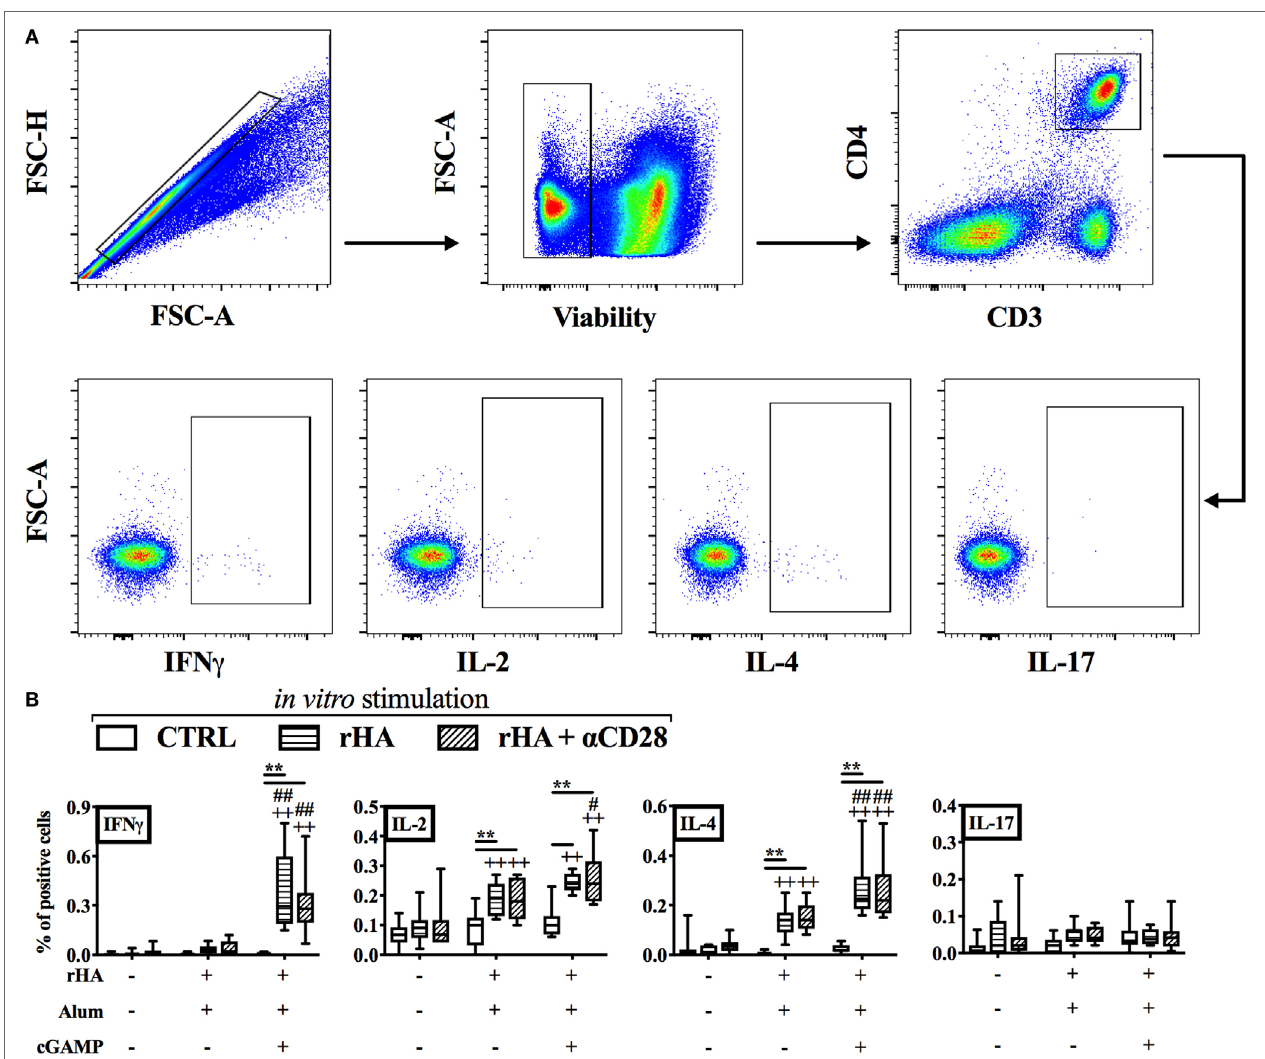
FigUre 3 | Immunization with (cGAMP + alum) induces Th1 polarization in early life. Newborn mice were immunized with alum or (cGAMP + alum) as indicated in Figure 2a . Ten days after boost [day of life (DOL) 24] splenocytes were harvested, re-stimulated for 18 h with recombinant hemagglutinin (rHA) in the presence or absence of the co-stimulus α CD28, and cytokine production by CD4 + T cells was assessed by intracellular flow cytometry. (a) Representative gating strategy. CD4 + T cells were defined as viable singlet CD3 + CD4 + cells. (B) Results are shown as the median, the 25th and 75th percentiles (boxes) and the 5th and 95th percentiles (whiskers) of 9–10 mice per group. ** p < 0.01 of in vitro CTRL vs. rHA vs. rHA + α CD28, ++ p < 0.01 of respective in vitro conditions compared to in vivo saline group, # p < 0.05 and ## p < 0.01 of respective in vitro conditions compared to in vivo alum group, determined by two-way ANOVA with Tukey’s post hoc